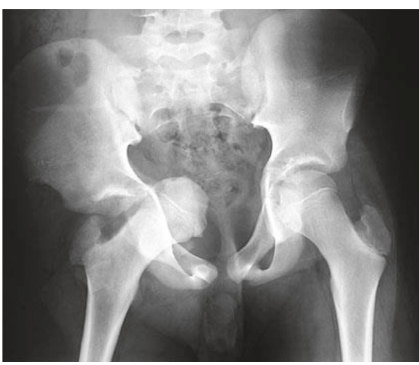
Figure 1: Displaced right acetabular fracture dislocation with anterior column fracture associated with a central migration of the right femoral head.